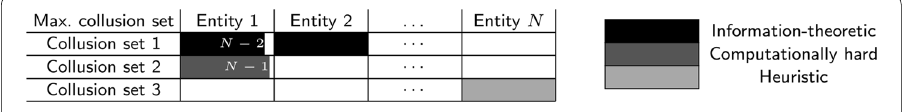
Fig. 4 Exemplary visualization of privacy guarantees for N entities and two collusion sets. Each collusion set (row) comprises of one or more entities (columns). The color of the collusion set corresponds to the level of privacy that can be